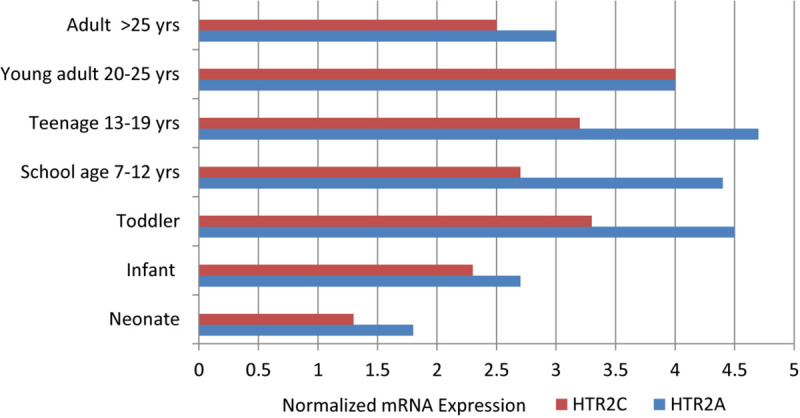
Normalized mRNA expression of serotonin receptors in human prefrontal cortex obtained from post-mortem cases of different ages, as adapted from Lambe et al. (2011).